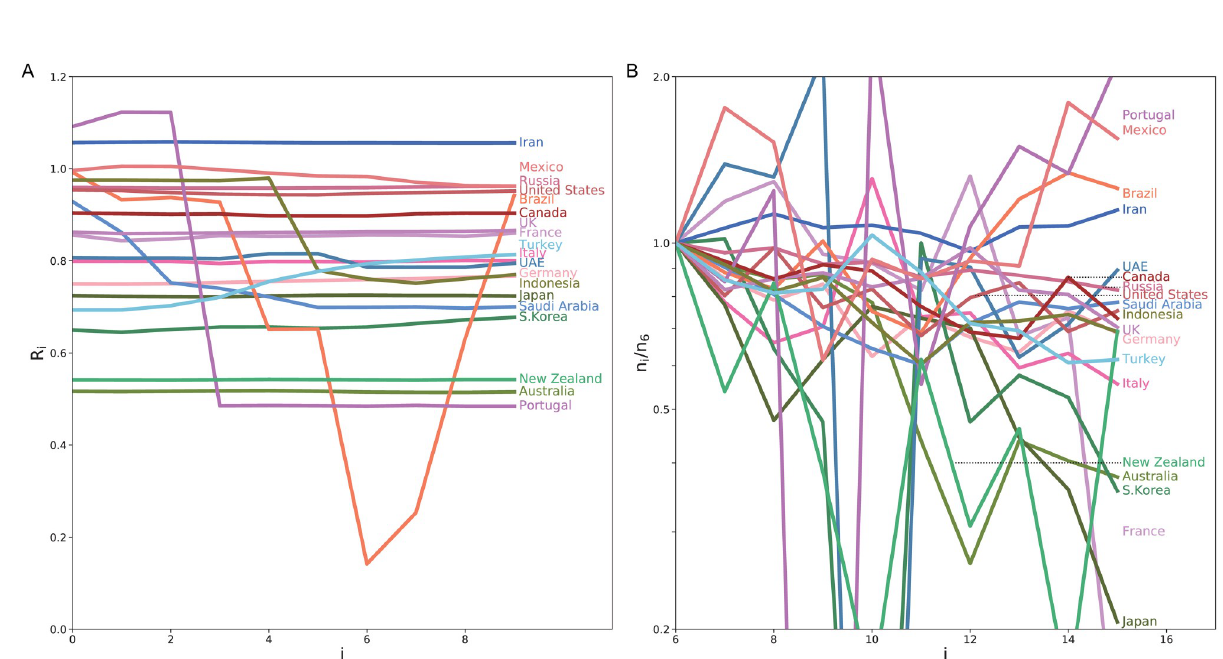
Fig 8. The minimum reproduction number achieved in each country. (A) The reproduction number for 10 days whose average takes minimum in each country. (B) Variation in the numbers of daily new cases; n i divided by n 6 . The period is shifted by 5 days, by taking account of the typical transmission